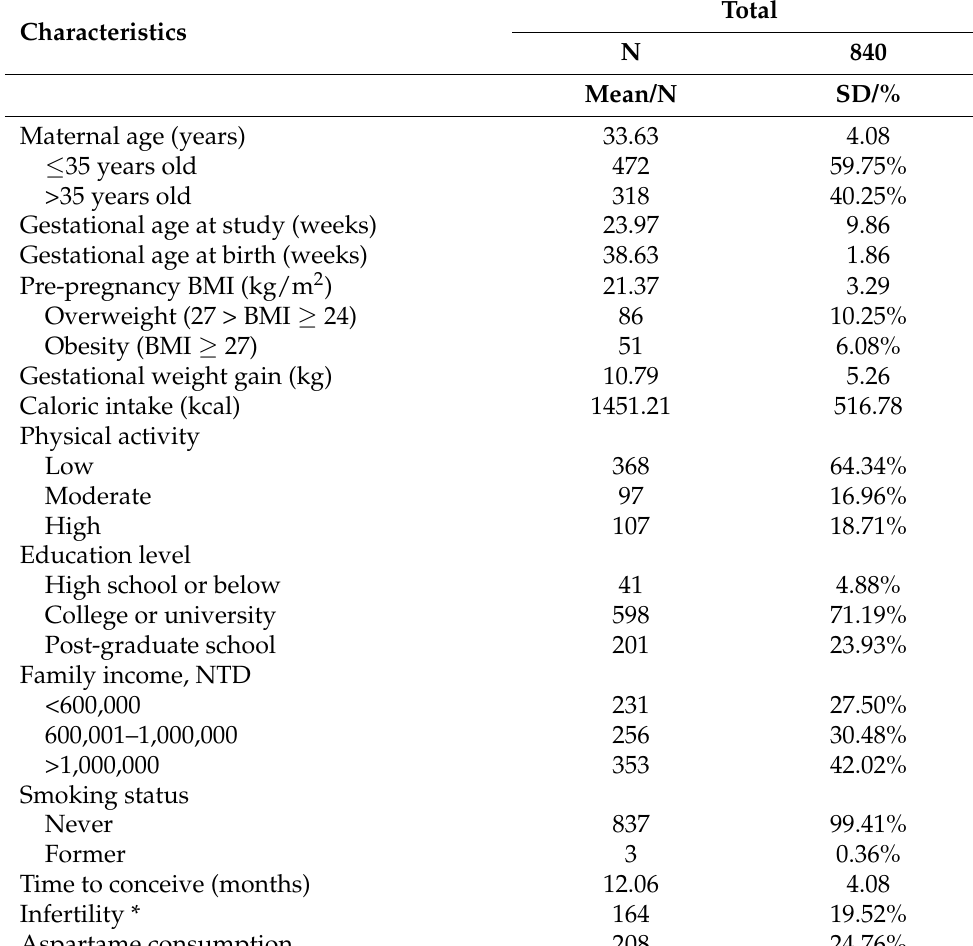
Table 1. Clinical characteristics of